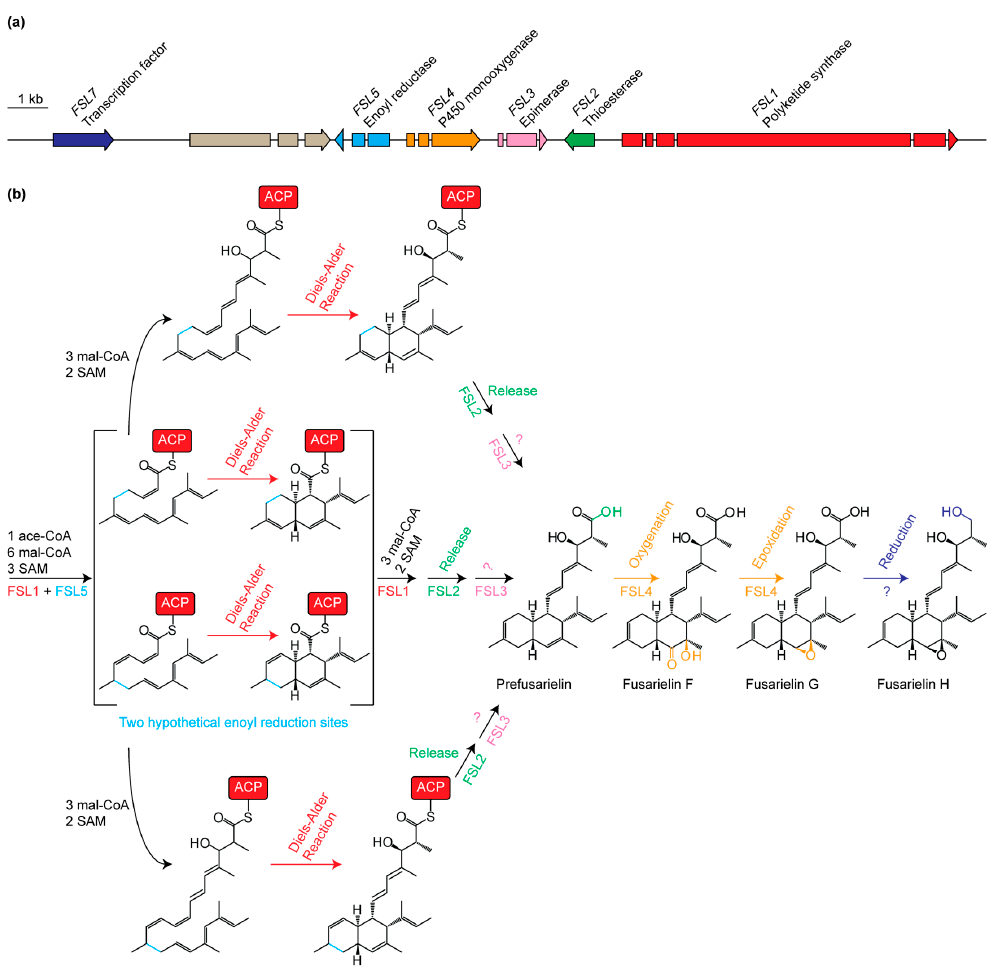
Figure 3. ( a ) Overview of the gene cluster with the six genes involved in fusarielin biosynthesis; ( b ) Possible pathways for fusarielin biosynthesis in Fusarium graminearum , which uses one acetyl-CoA (ace-CoA), nine malonyl-CoA (mal-CoA), and five S-Adenosylmethionine (SAM) subunits. The Diels-Alder reaction can occur at the heptaketide stage or when chain elongation has completed. The growing polyketide chain is attached to the acyl carrier protein (ACP) domain of FSL1. Two possible enoyl reduction sites are highlighted.